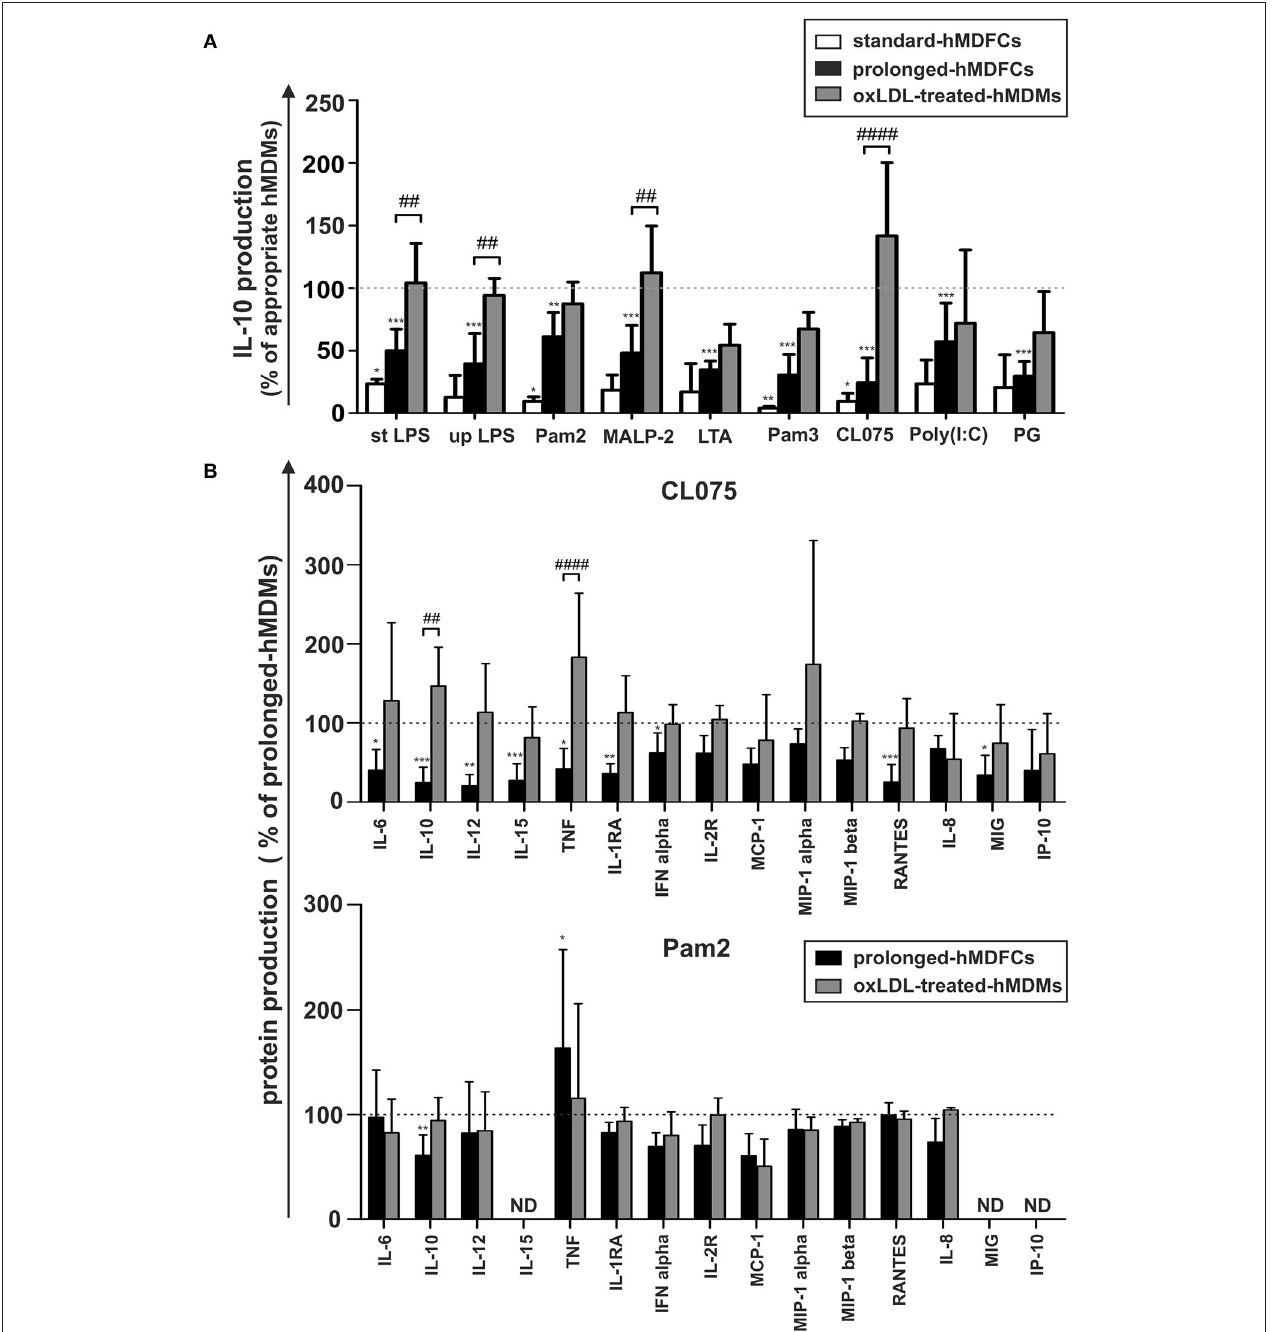
FIGURE 6 | Comparison of IL-10 production by standard-hMDFCs, prolonged-hMDFCs, and oxLDL-treated-hMDMs (A) , and comparison of different cytokines production by prolonged-hMDFCs, and oxLDL-treated-hMDMs (B) . Standard/prolonged-hMDMs/hMDFCs were obtained as indicated in Materials and Methods, and Figure 1 . Cells were then stimulated with different PAMPs for 24h. Levels of cytokines in supernatants were determined by a multiplex immunoassay and/or ELISA (IL-10 and TNF) and normalized to protein content in corresponding cell cultures. Results for hMDFCs and oxLDL-treated-hMDMs were expressed as a percent of cytokine production by corresponding standard- or prolonged-hMDMs (100% indicated with dashed horizontal lines). Bars and error bars represent means ± SD from at least three independent experiments (each in triplicate, n ≥ 9). * p < 0.05, ** p < 0.01, *** p < 0.001 vs. hMDMs, ## p < 0.01, #### p < 0.001 hMDFCs vs. oxLDL-treated